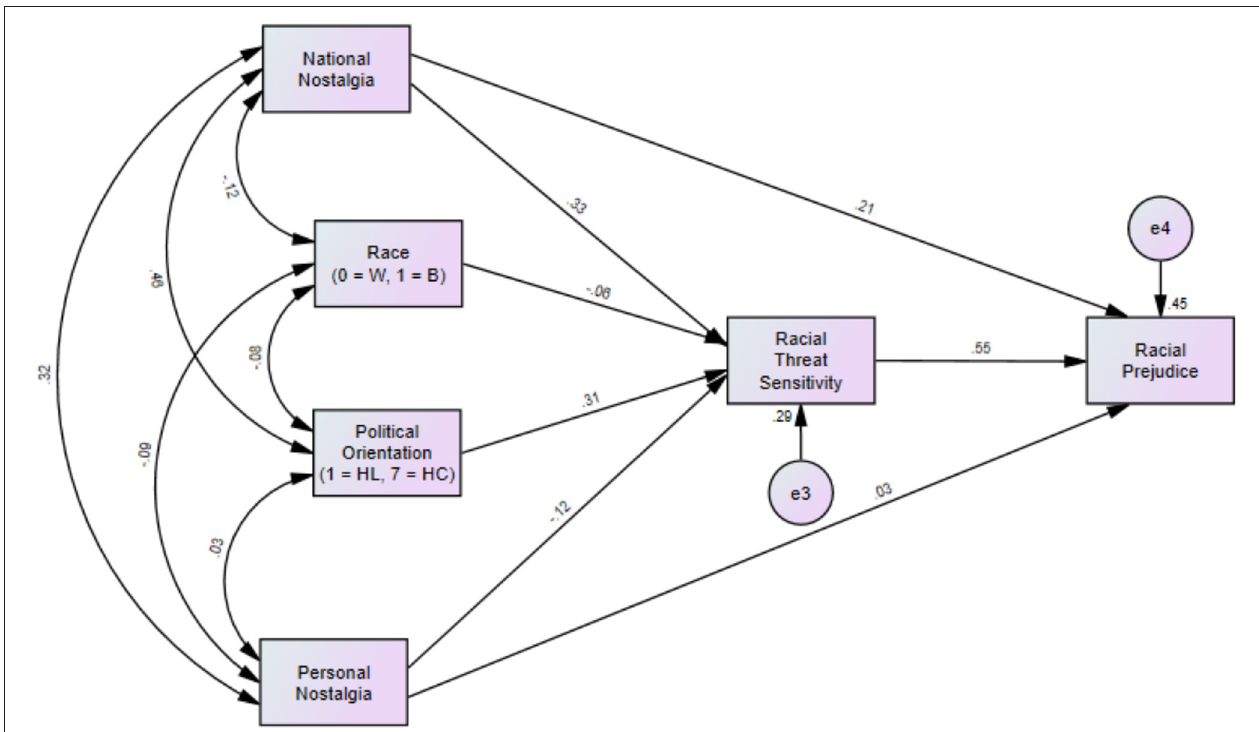
FIGURE 7 | Path analysis of relationships between national/personal nostalgia and prejudice, mediated by racial threat sensitivity (Model 3). Note. Path coefficients represent standardized estimates. Indirect effect of national nostalgia on racial prejudice through racial threat sensitivity was significant [ β = 0.18; 95% bias-corrected CI (0.10,